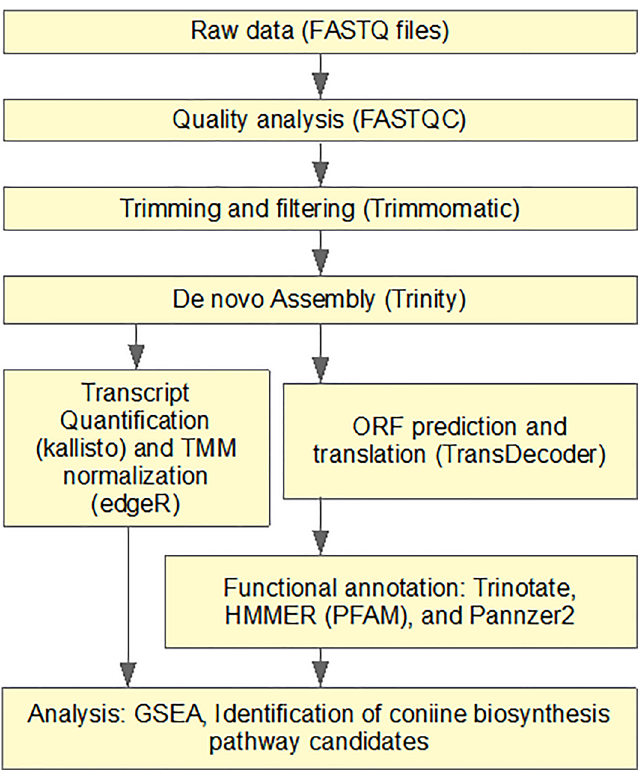
Figure 2. Outline of the data processing. The LibreOffice Draw v6.4 (https:// www. libre office. org/ disco ver/ draw/) was used to draw this